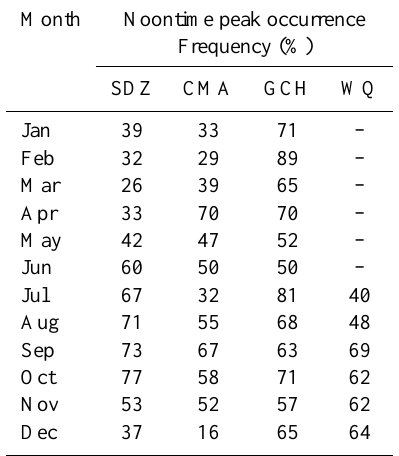
Table 1. Seasonal variation of noontime-peak occurrence frequency